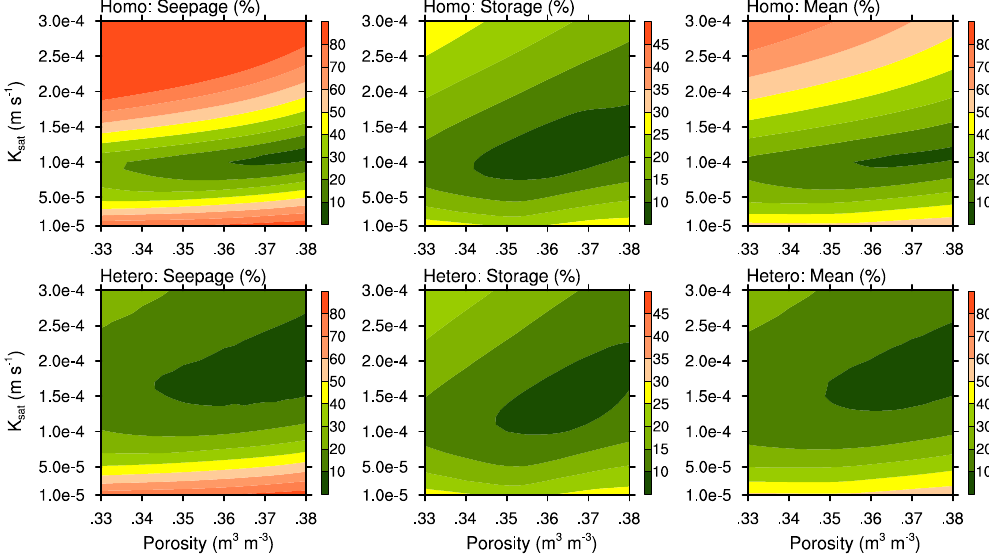
Figure 6. Relative model error ( e ) of seepage flow and water storage and the mean error for M4_Homo (upper panels) and M4_Hetero (lower panels; with K sat,sf =1.9 × 10 − 5 ms − 1 ) over the parameter space of K sat and porosity.